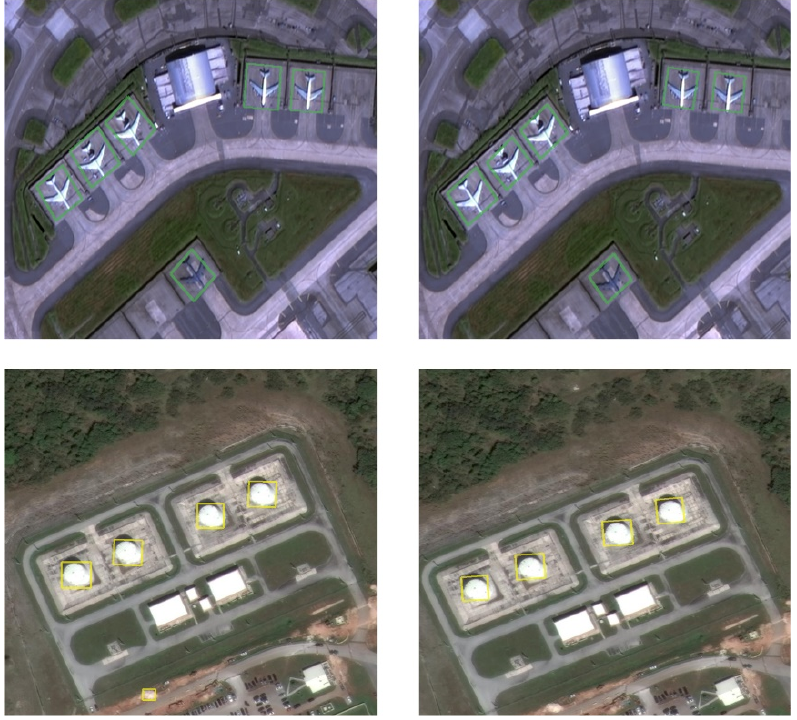
Figure 12. Comparison of large-scale target detection results in DOTA-GF dataset images ( left : RetinaNet method; right : our proposed